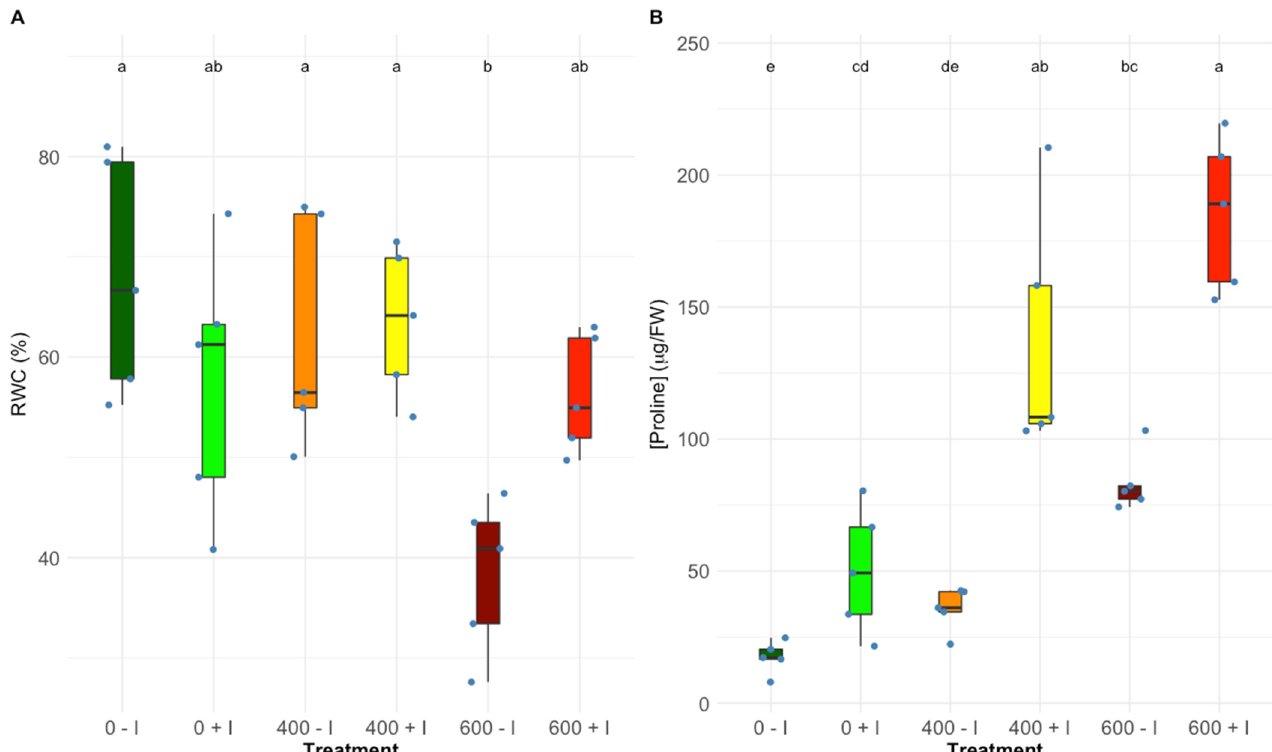
Figure 6. Leaves, ( A ) relative water content (RWC) and proline concentration ( B ) of non-inoculated and inoculated Halimione portulacoides individuals (average ± standard error, N = 5), along with the tested NaCl concentrations. Letters indicate significant differences between treatments at p < 0.05.